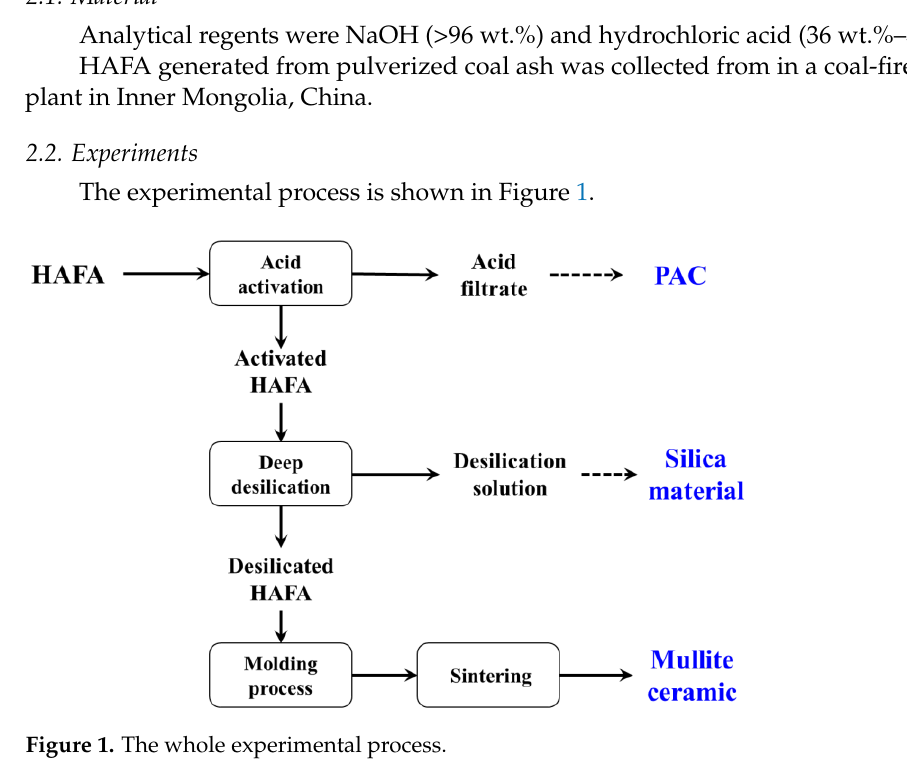
Figure 1. The whole experimental process.